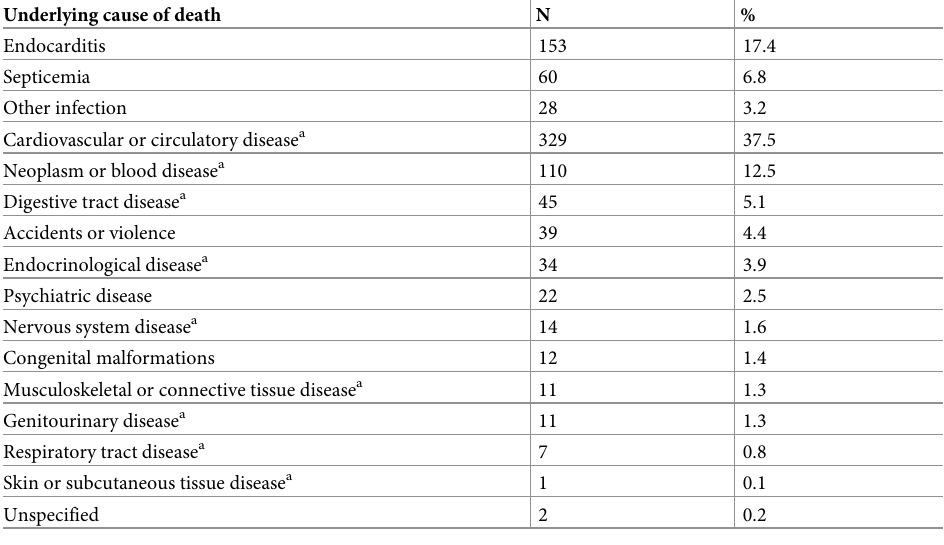
Table 4. Underlying causes of deaths in infective endocarditis patients that died within 10 years after the admis- sion (n =